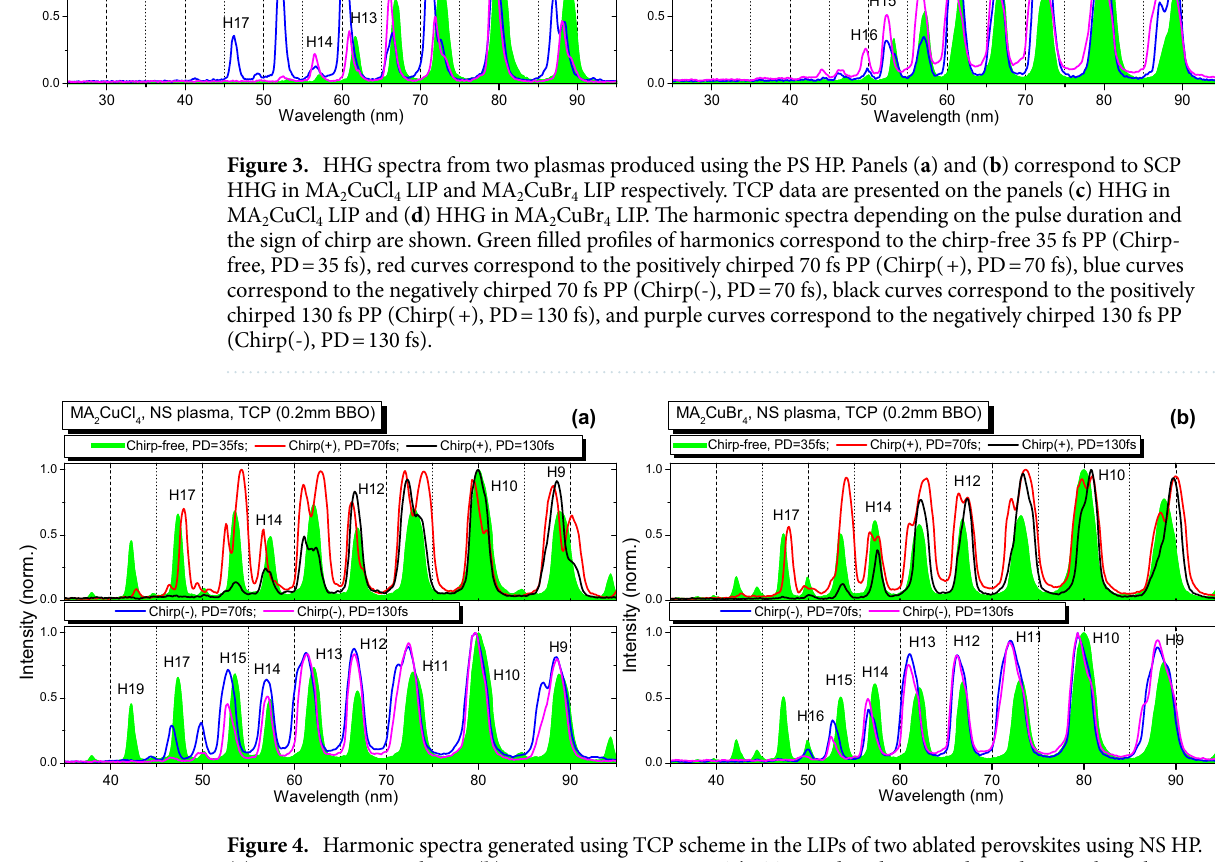
Figure 4. Harmonic spectra generated using TCP scheme in the LIPs of two ablated perovskites using NS HP. ( a ) HHG in MA 2 CuCl 4 LIP. ( b ) HHG in MA 2 CuBr 4 LIP. The TCP-induced spectra depending on the pulse duration and the sign of chirp are shown. Green filled profiles of harmonics correspond to the chirp-free 35 fs PP (Chirp-free, PD = 35 fs), red curves correspond to the positively chirped 70 fs PP (Chirp( +), PD = 70 fs), blue curves correspond to the negatively chirped 70 fs PP (Chirp(-), PD = 70 fs), black curves correspond to the positively chirped 130 fs PP (Chirp( +), PD = 130 fs), and purple curves correspond to the negatively chirped 130 fs PP (Chirp(-), PD = 130